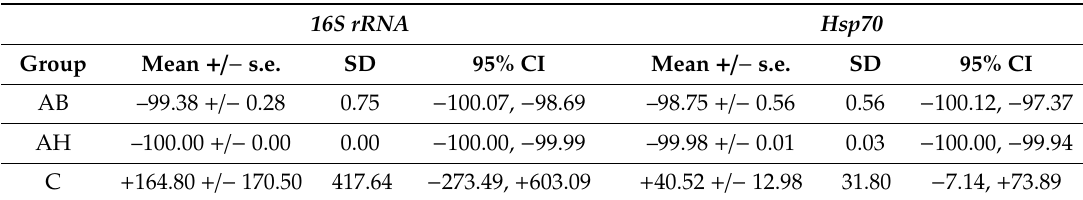
Table 5. Treatment e ff ect on N. ceranae abundance.